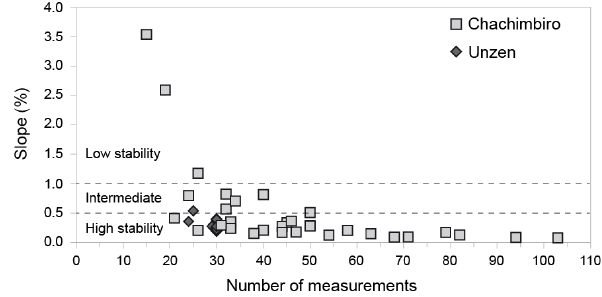
Figure 4. Results of the stability analyses for the Chachimbiro and Unzen data sets. Note that there is a large scattering for Chachim- biro data set below 40 measurements while the Unzen data set has much less dispersed